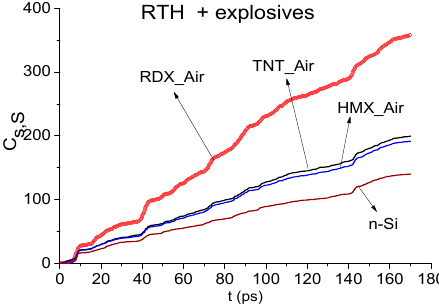
Figure 6. Time-dependent ICC C s , S computed for the RTH signal and the standard signals RDX_Air, TNT_Air, HMX_Air and n-Si in the time interval [0, 180]